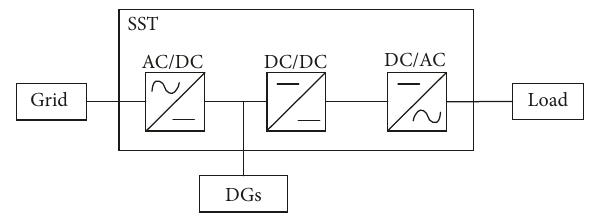
Figure 1: A typical tertiary-structure solid state